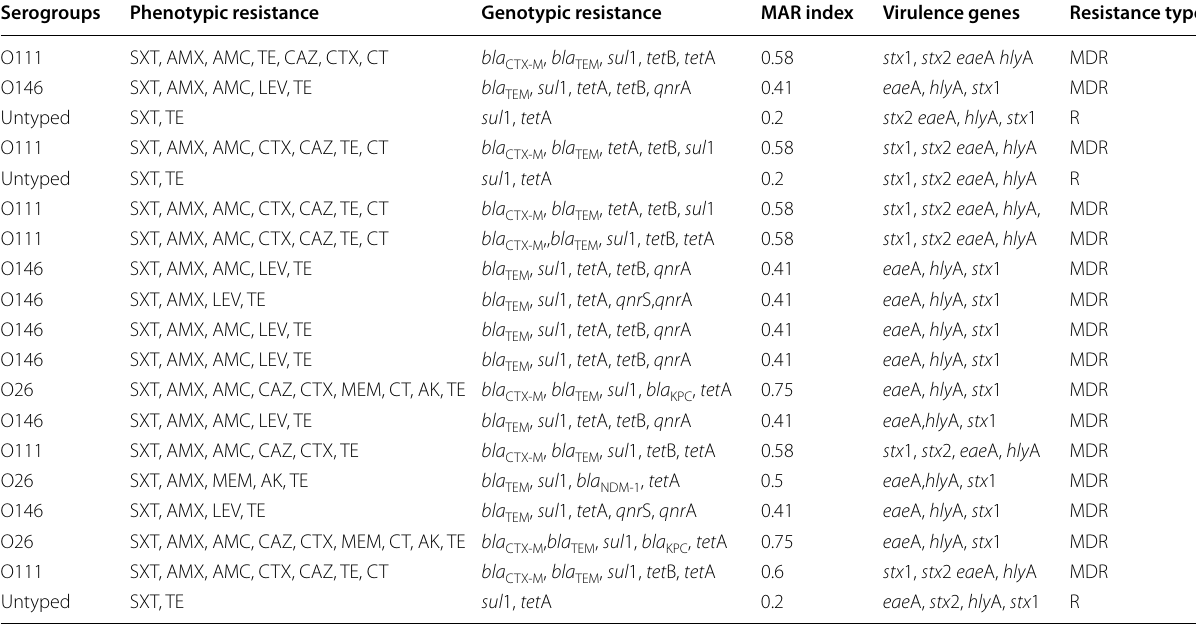
MAR multiple antibiotic resistance